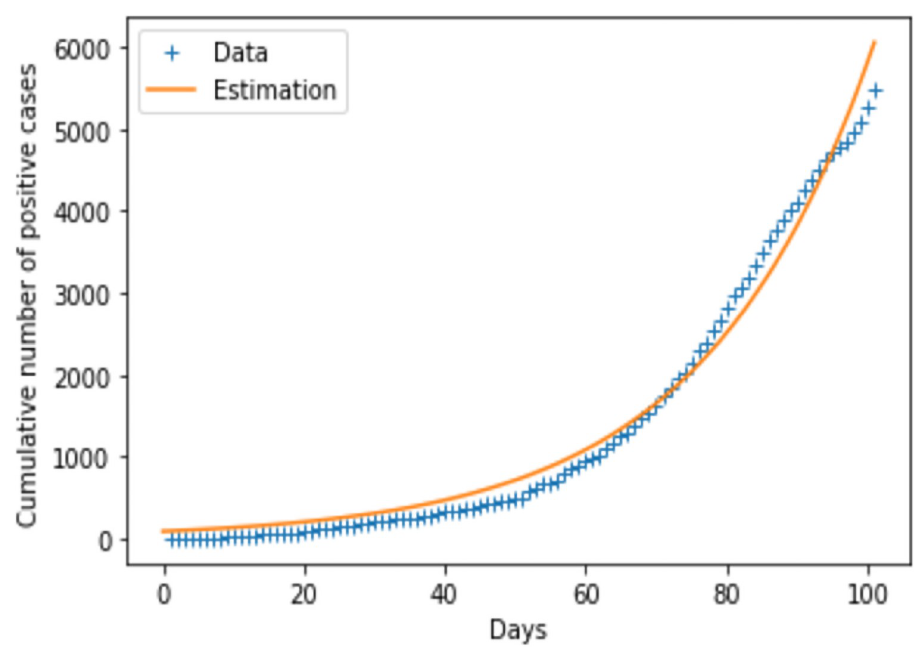
Fig 2. Fitting data to the model for parameters estimation.